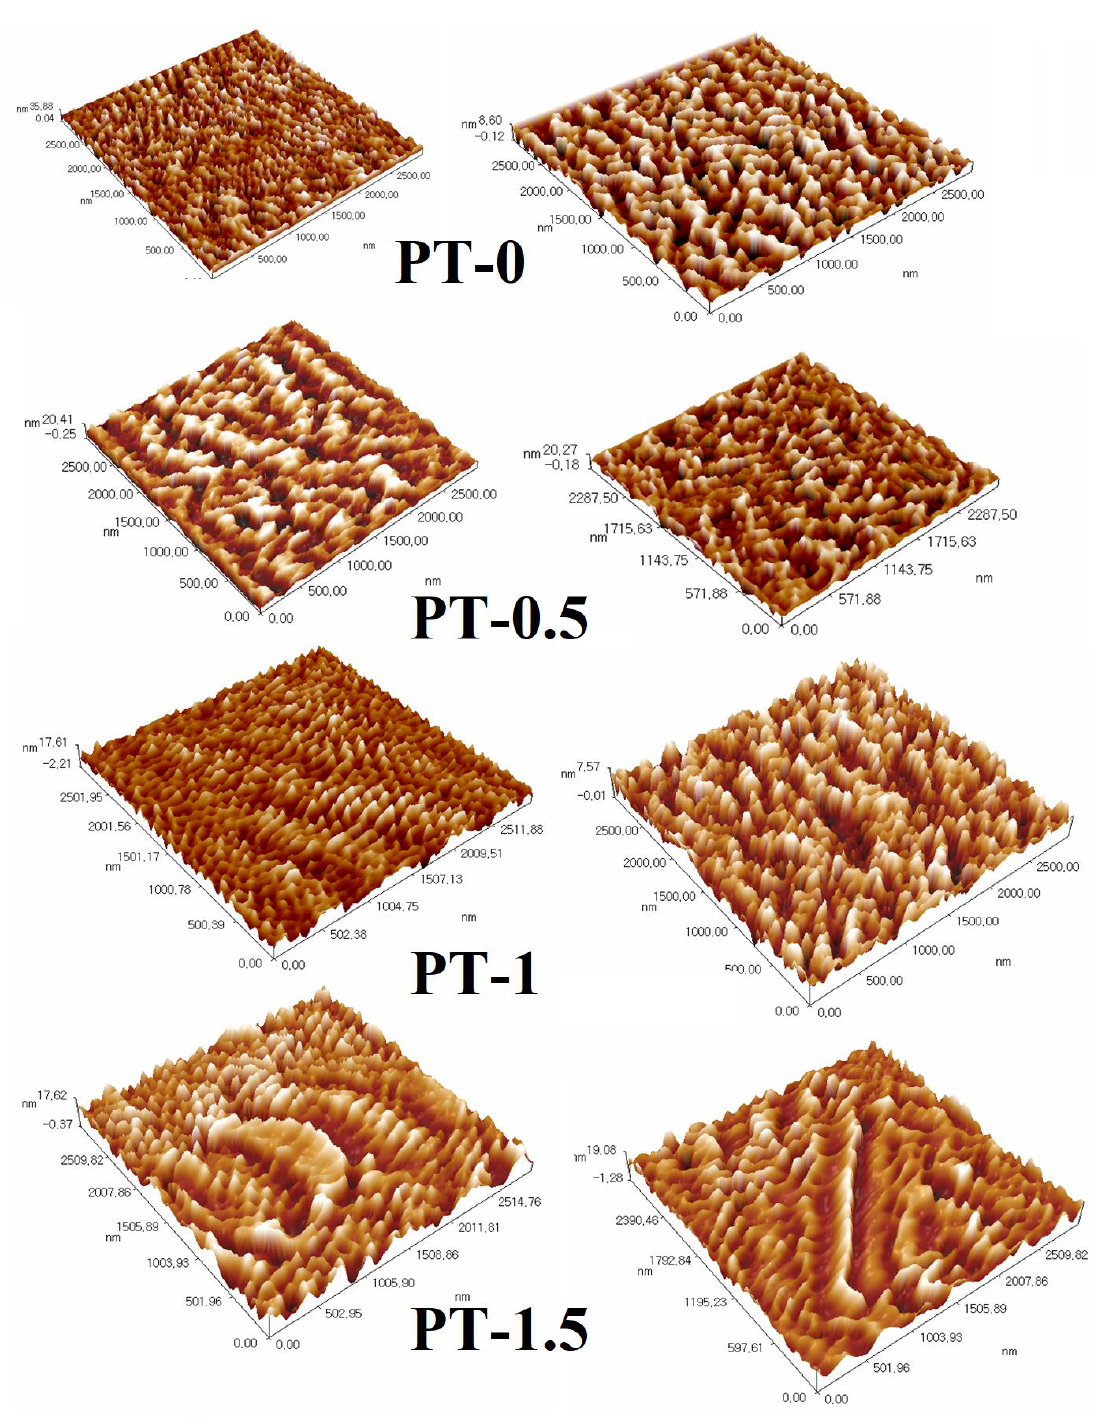
Figure 7. Three-dimensional (3-D) atomic force microscope (AFM) images of the top and bottom surfaces of the PVC membranes at different TiO 2 amounts: (PT-0 ) 0 gm TiO 2 ; ( PT-0.5 ) 0.5 gm TiO 2 ; ( PT-1 ) 1 gm TiO 2 ; and ( PT-1.5 ) 1.5 gm TiO 2 , top surface (left) and bottom surface